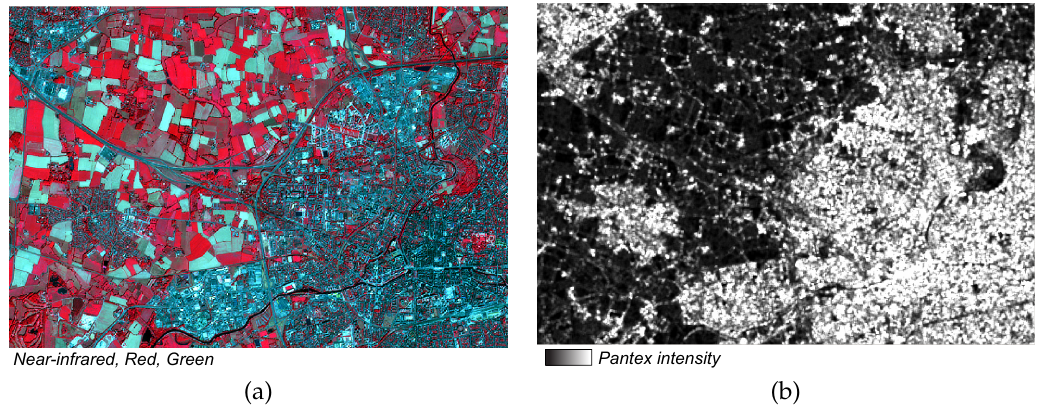
Figure 4. PANTEXcriterion computed on Sentinel-2 image: ( a ) original Sentinel-2 image; ( b ) minimum PANTEX value. As one can observe, local contrasts issued from urban areas are accurately